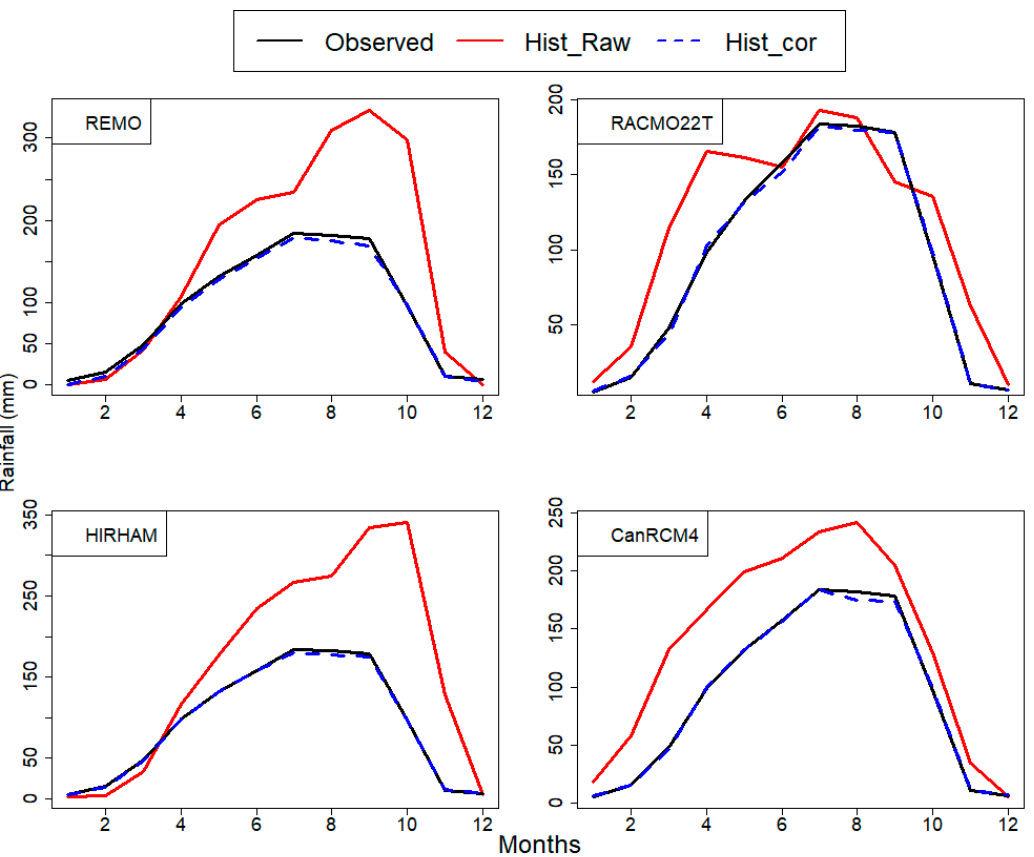
Figure 5. Comparison of raw and bias corrected rainfall with observation at seasonal scale over the historical period 1971–2005.